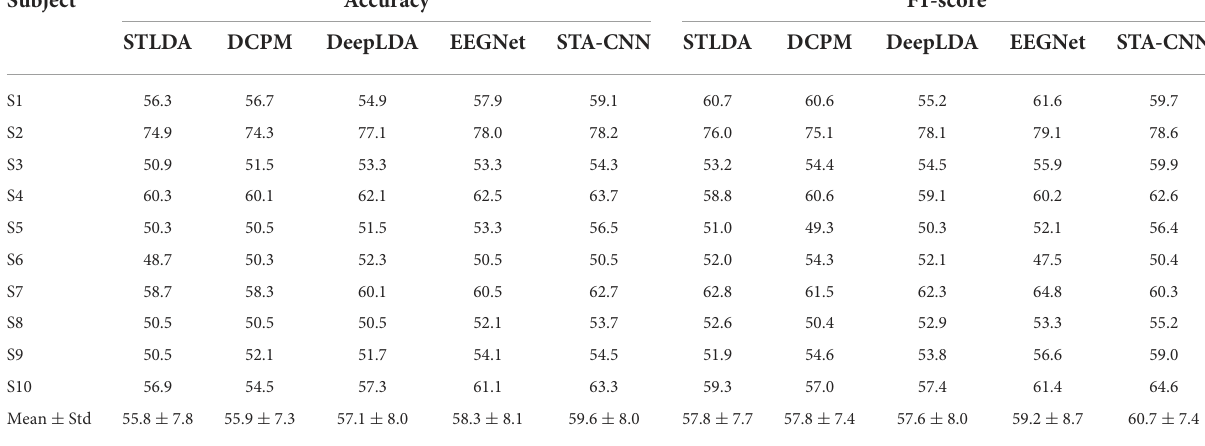
TABLE 2 The classification accuracy and F1-score of 10 subjects using five methods in the first stage